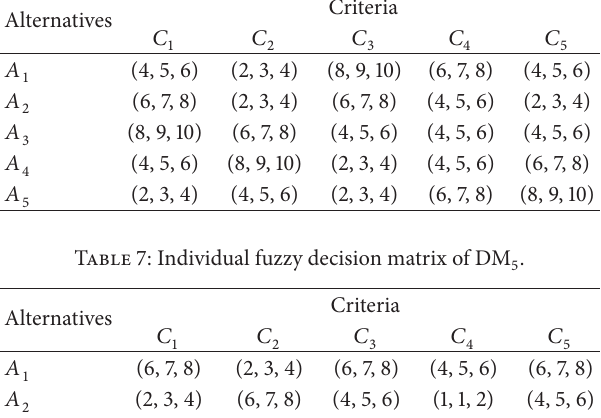
Table 6: Individual fuzzy decision matrix of DM 4 . Alternatives